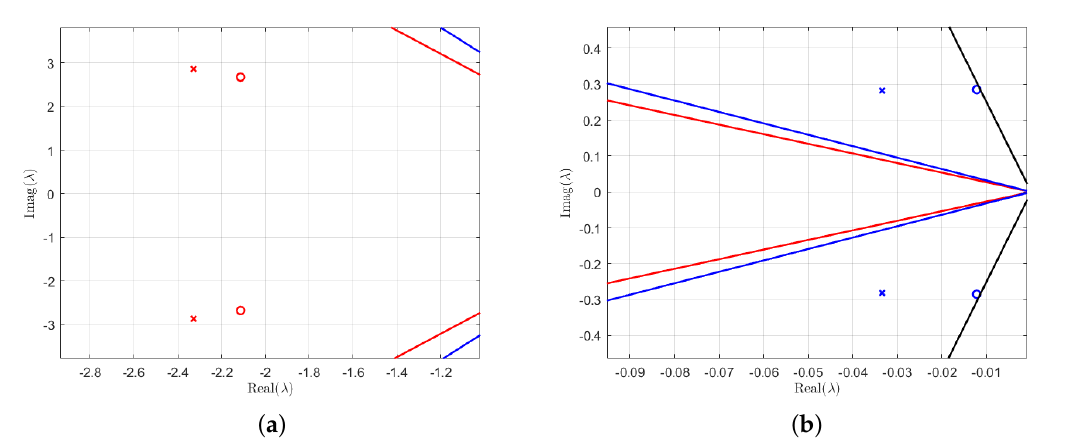
Figure 10. Eigenvalues of short period ( a ) and phugoid ( b ) for the three-surface testbed (circles) and three-surface with reassigned dynamics (crosses) via LQR. Lines represent limits for Level 1 flying qualities (black lines: phugoid, blue lines: Category B short period, red lines: Category A short